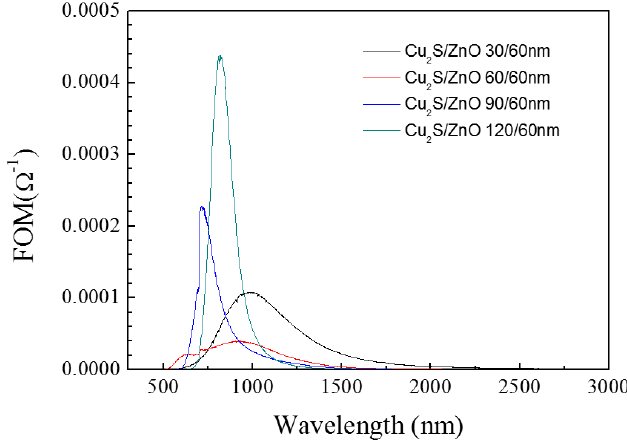
Figure 11. The figure of merit of Cu 2 S/ZnO/glass complex films for different thickness.